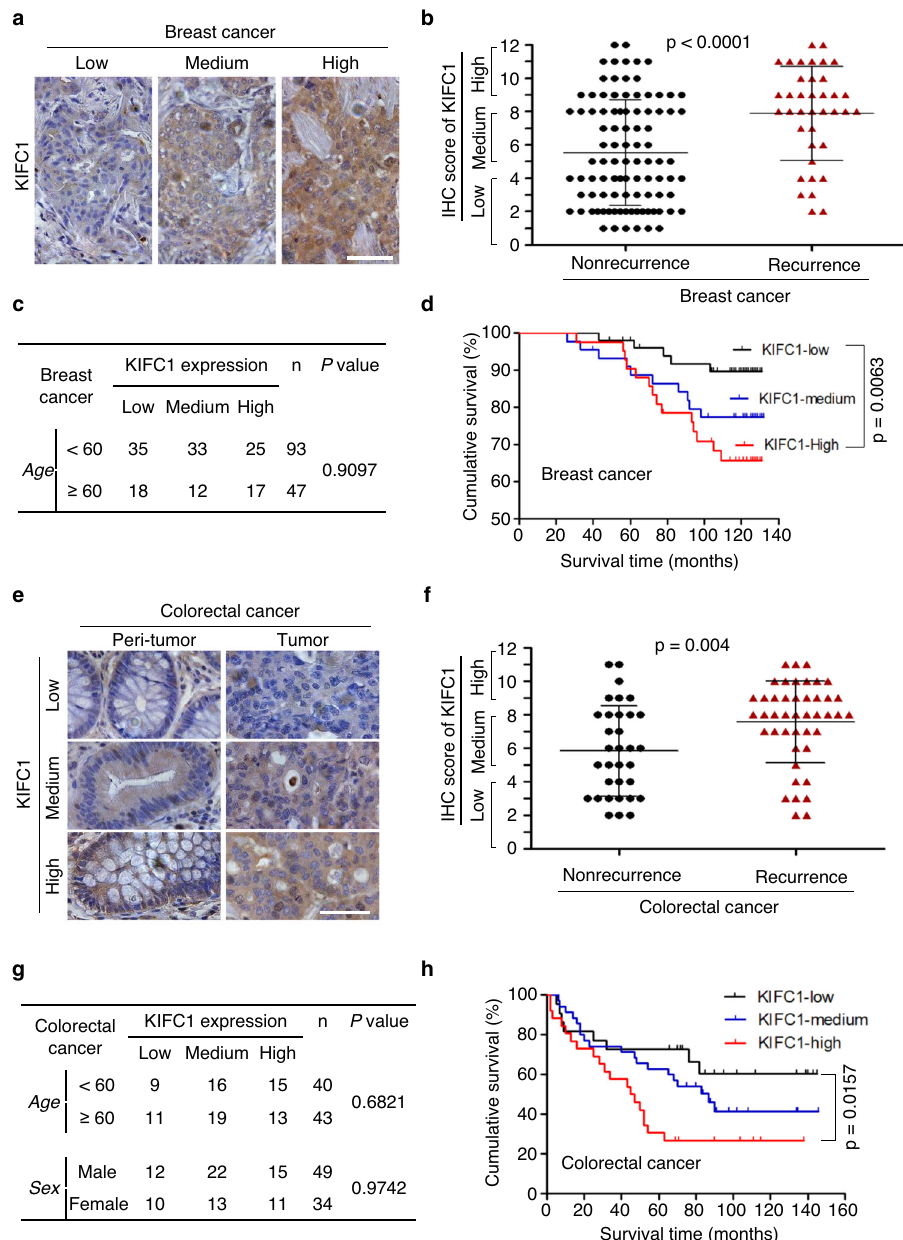
Fig. 1 KIFC1 predicts human tumor recurrence. The correlation of KIFC1 protein expression and tumor recurrence or poor prognosis in breast cancer ( n = 140, a – d ) or colorectal cancer ( n = 83, e – h ) tissue chips. a, b, e , f Data are representative of the KIFC1 stained tumor or adjacent non-tumor tissues ( a, e ) (scale bar, 50 μ m) with quantitative analysis of clinical samples of tumor recurrence or non-recurrence ( b, f ). KIFC1 expression was classi fi ed as high, medium, or low according to the staining signals. Two-tailed t test p values: p = <0.00001 ( b ). c, d, g , h The tables show the relative levels of KIFC1 expression with patient age or gender in breast cancers ( c ) or colorectal cancers ( g ). Kaplan – Meier plot of overall survival of patients with breast cancer ( d ) or colorectal cancer ( h ) strati fi ed by the KIFC1 expression level. A log-rank test was used for statistical analysis. All data presented in this fi gure show mean values ± SD. Statistical signi fi cance was determined by Two-tailed t test. Source data are provided as a Source Data fi